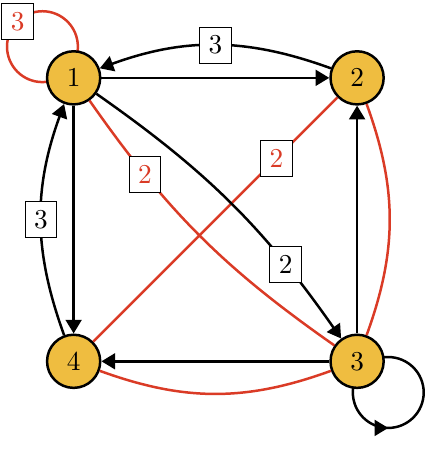
Figure 8 . Quiver diagram for phase A of H 4